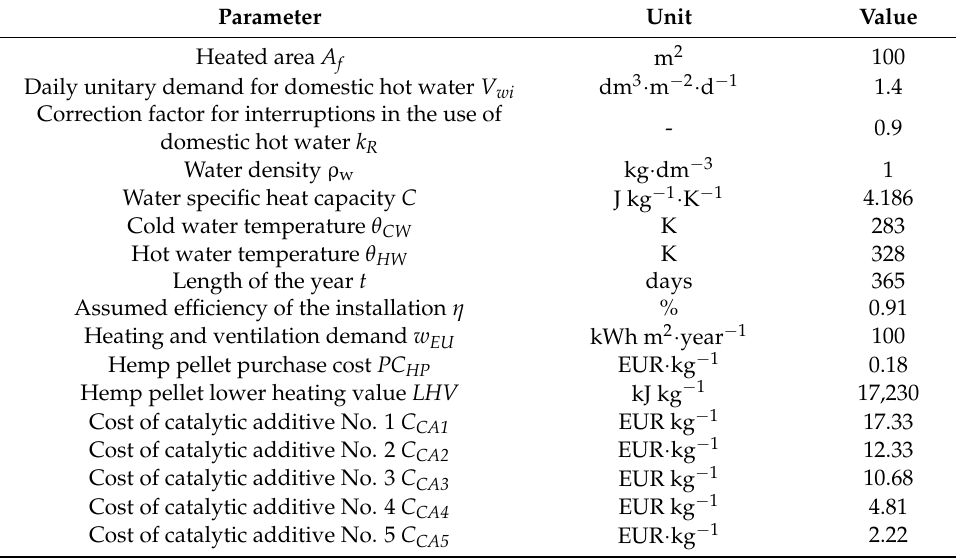
Table 8. Adopted assumptions for the economic analysis. Parameter